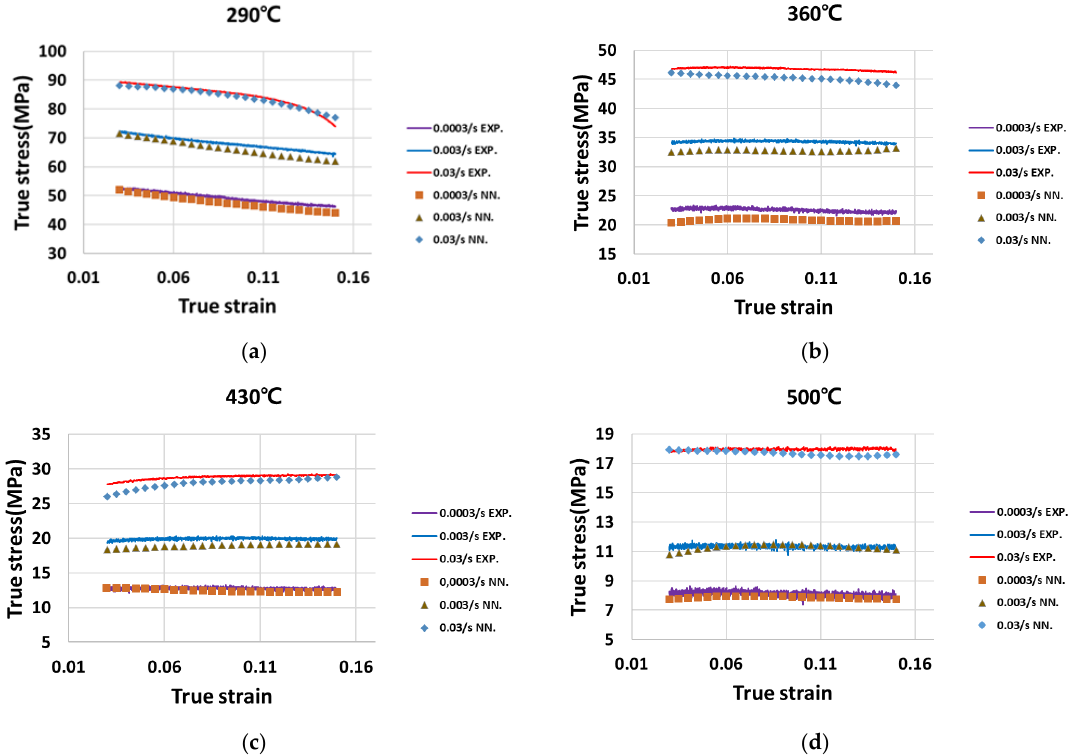
Figure 6. True stress–strain curves by Neural Network at ( a ) 290 °C, ( b ) 360 °C, ( c ) 430 °C, and ( d ) 500 °C.